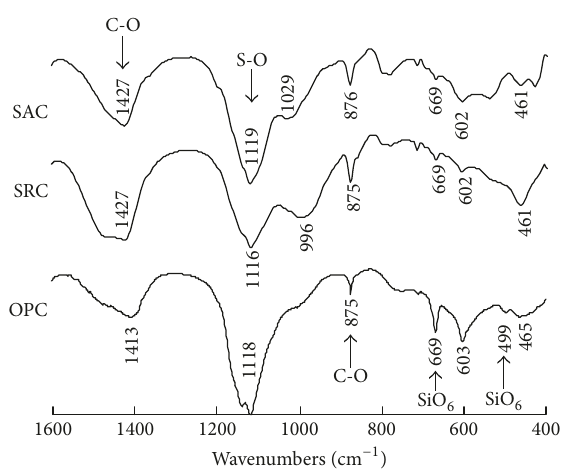
Figure 5: XRD patterns of mortars after 1-year immersion in sulfate solution. S: quartz; CC: calcite; E: ettringite; T: thaumasite; G: gypsum.